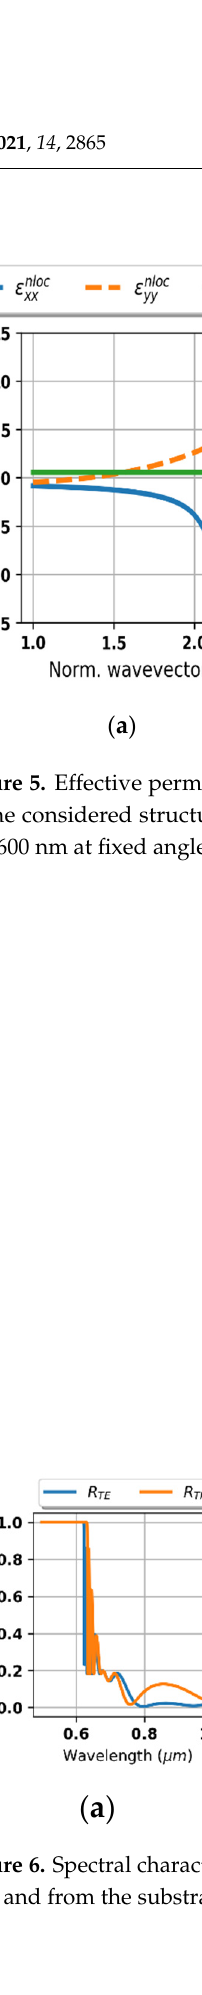
( h ) Figure 7. Spectral characteristics of transmittance for waves impinging from the air side ( a – d ) and substrate side ( e – h ) at various angles of incidence ( a ) 5°, ( b ) 25°, ( c ) 45°, ( d ) 65°, ( e ) 185°, ( f ) 205°, ( g ) 225°, and ( h ) 245°.